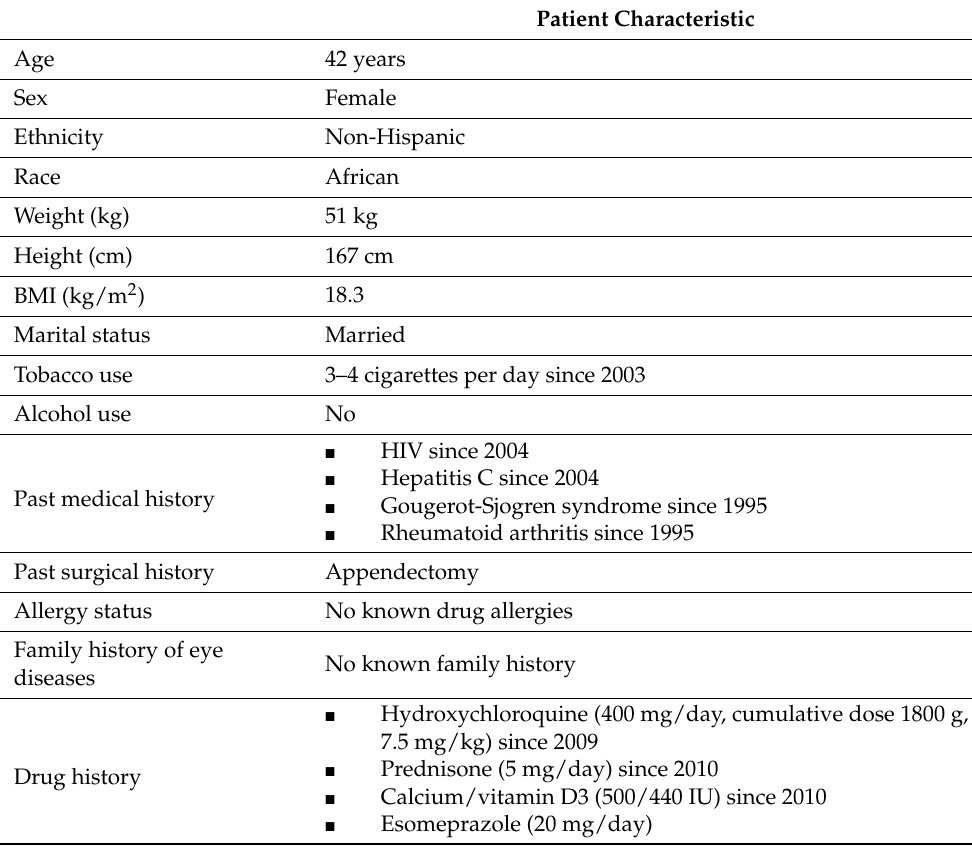
Table 1. The patient demographic, medical, and drug history